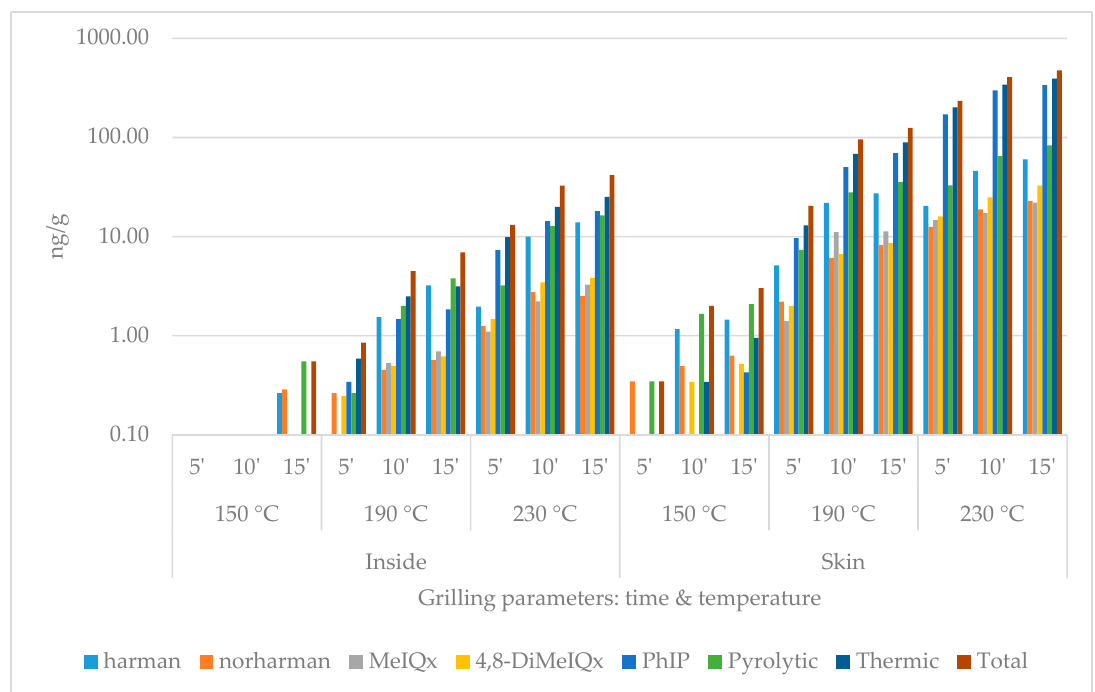
(logarithmic scale).